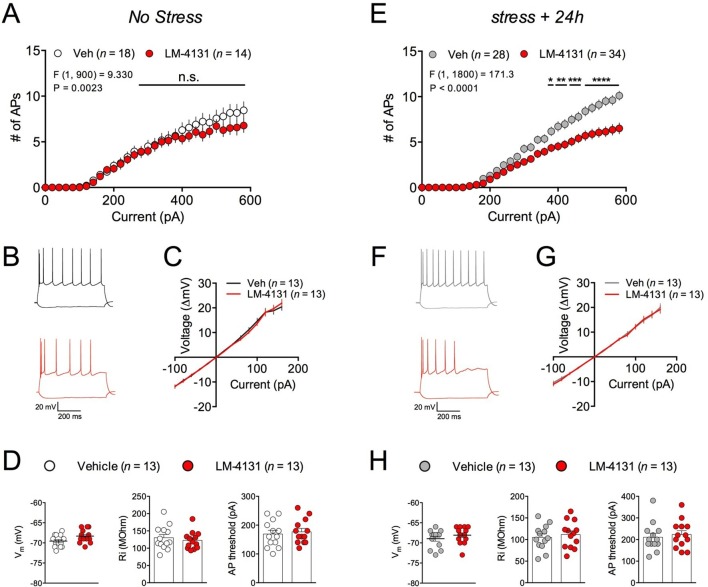
Effects of COX-2 inhibition on ex vivo BLA neuronal excitability.(A–B) Effects of LM-4131 (10 μM) on BLA neuron excitability, (C) I/V relationship, (D) resting membrane potential (Vm), input resistance (Ri), and action potential (AP) threshold in non-stressed mice. (E–F) Effects of LM-4131 on BLA neuron excitability, (G) I/V relationship, (H) resting membrane potential (Vm), input resistance (Ri), and action potential (AP) threshold in mice 24 hr after foot-shock stress. F and P values for drug effects by two-way ANOVA shown in (A and E), *p<0.05, **p<0.01, ***p<0.001, ****p<0.0001 by post hoc Holm-Sidak test in (A) and (E).